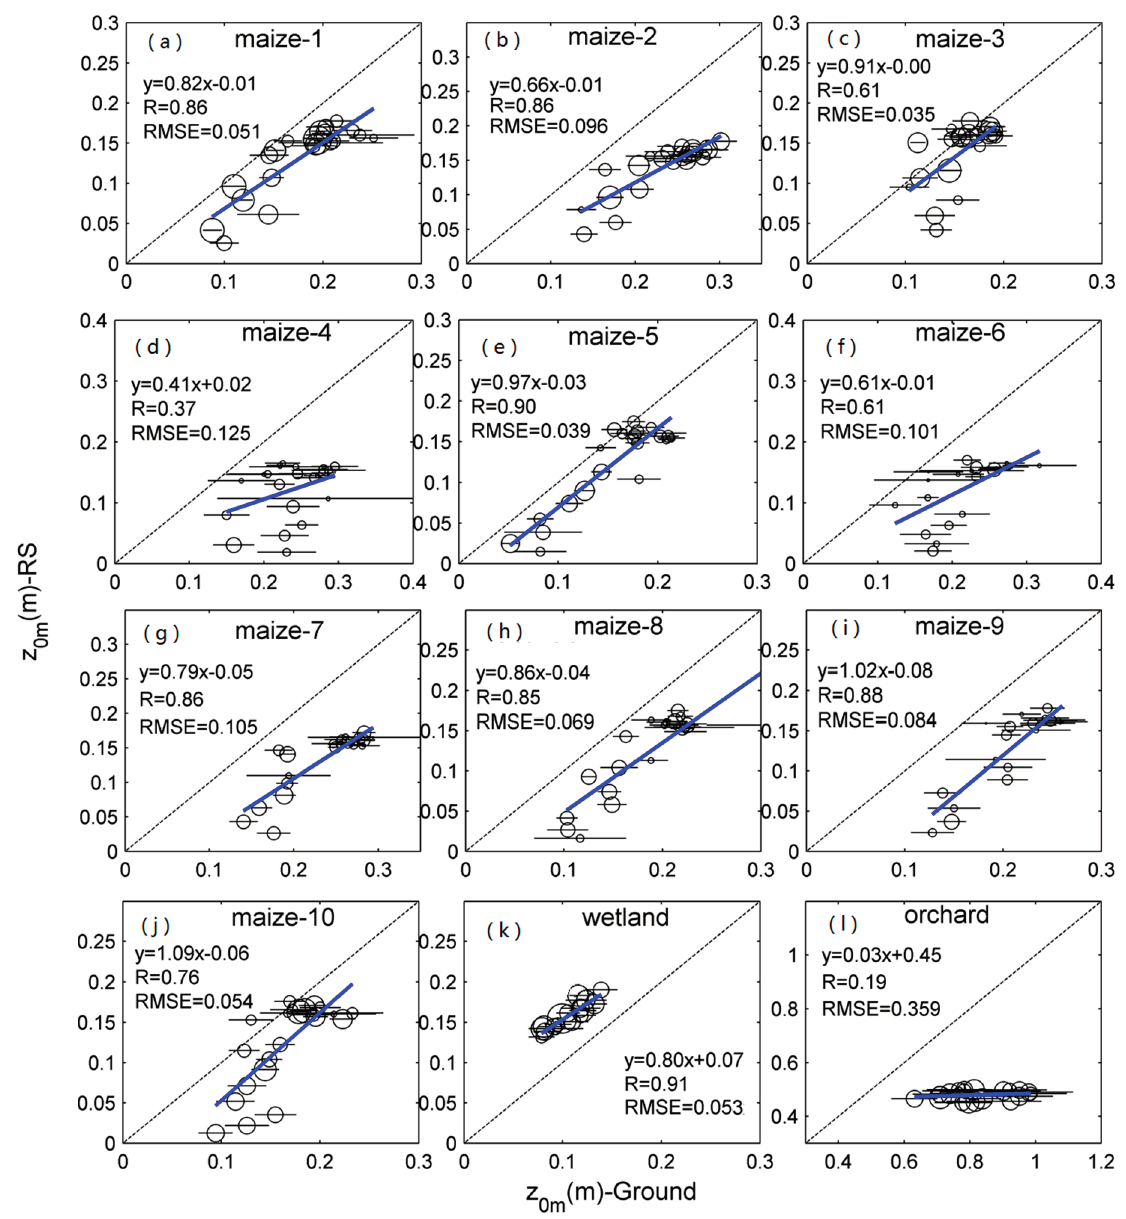
Figure 8. Comparison between the estimated aerodynamic roughness length and the ground measurements from EC experimental sites ( a–l ) in the middle reach of the Heihe River Basin in 2012. Each circle is the area—Averaged value over five days. The diameters of the circle scale with the number of degrees of freedom (equivalent to the number of observations) for each robust regression. The error bars indicate the 95% confidence intervals of the regression